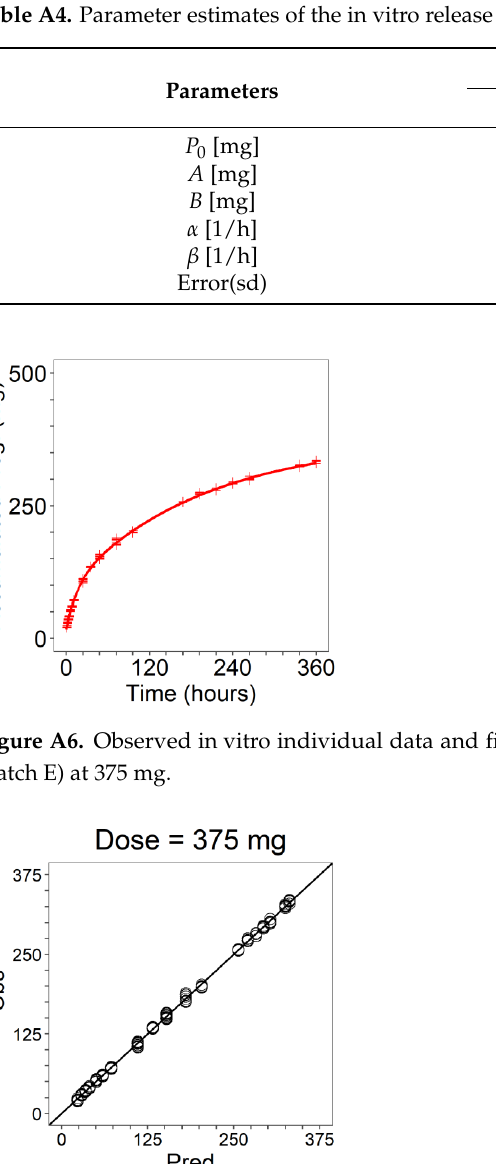
Figure A5. Observed in vitro individual data and fitted cumulative release profiles normalized by the progesterone dose loaded in the ring for all dose levels.